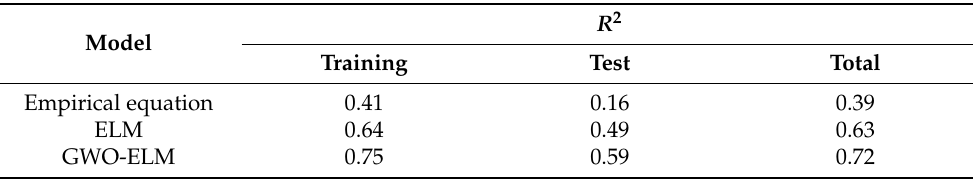
Figure 13. Comparison between measured and predicted frequency: ( a ) GWO-ELM; ( b ) ELM; ( c ) Empirical equation. Table 5. Statistical criteria for predicting frequency.